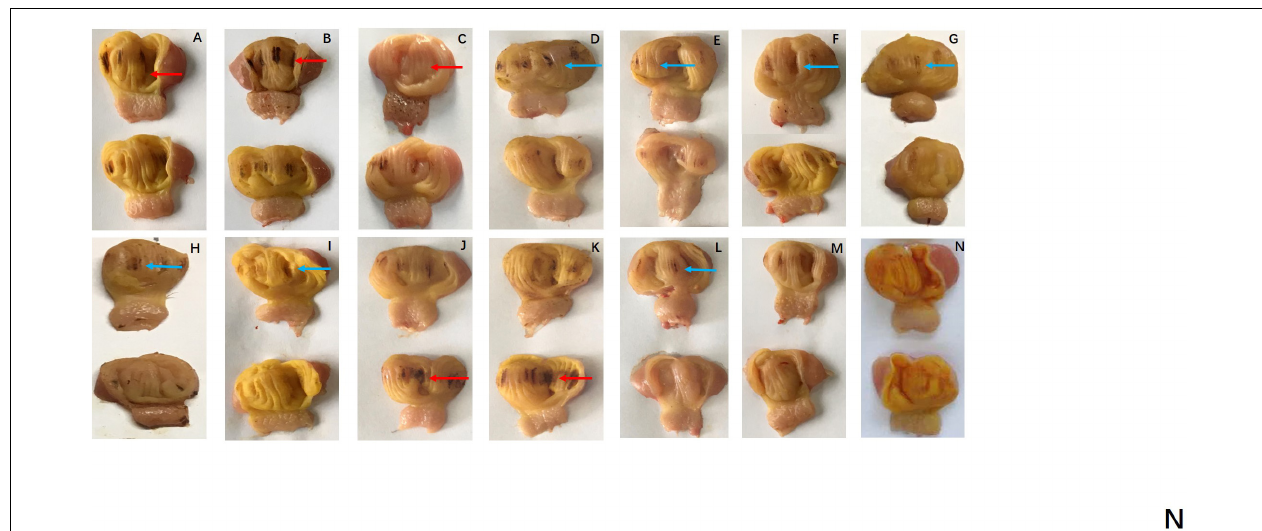
FIGURE 2 | Gizzard ulcerations of chicken progenies post-inoculation with FB or DON, or synergetic inoculation. (A) FB 1 6 µ g; (B) FB 1 12 µ g; (C) FB 1 24 µ g; (D) FB 2 12 µ g; (E) FB 2 24 µ g; (F) FB 2 48 µ g; (G) FB 1 3.6 µ g + FB 2 1.2 µ g + FB 3 1.2 µ g; (H) FB 1 7.2 µ g + FB 2 2.4 µ g + FB 3 2.4 µ g; (I) FB 1 14.4 µ g + FB 2 4.8 µ g + FB